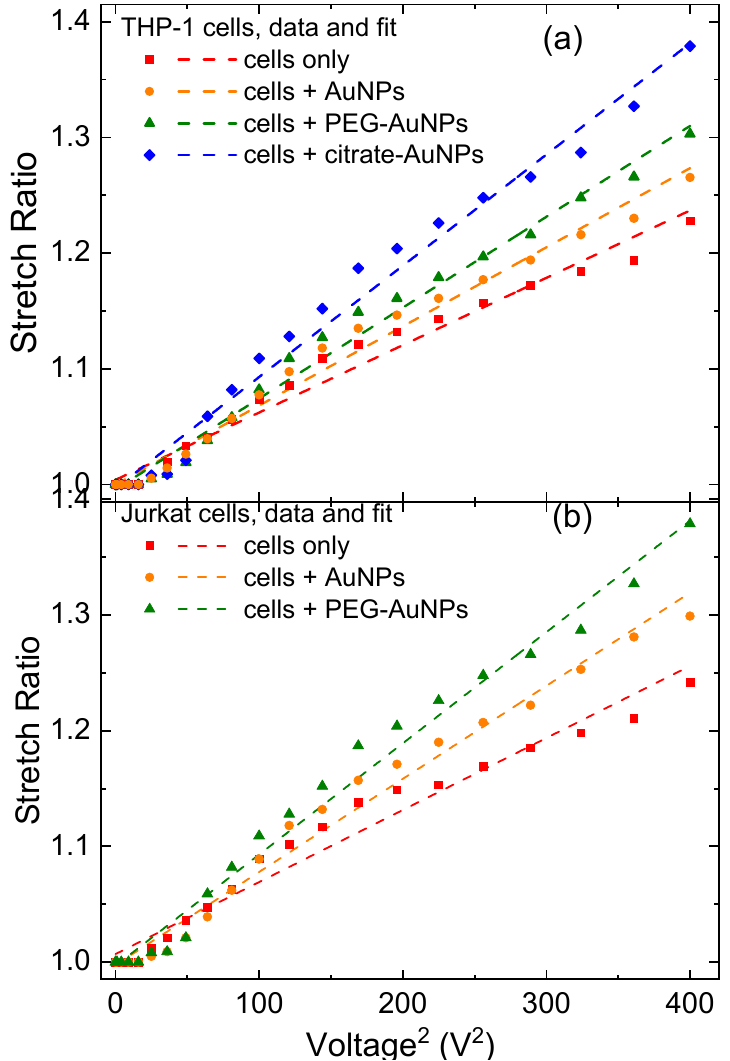
Figure 6. ( a ) Stretch ratio plotted as a function of the squared applied voltage, for THP-1 white blood cells (WBC), for the purpose of linear fit. Points represent the same values as in Figure 5, while the dashed line represents the fit values. It is clear that there are different deformation regimes, as indicated by the crossover points (where the imaginary line connecting the points crosses the line of the fit); ( b ) same analysis for Jurkat cells.